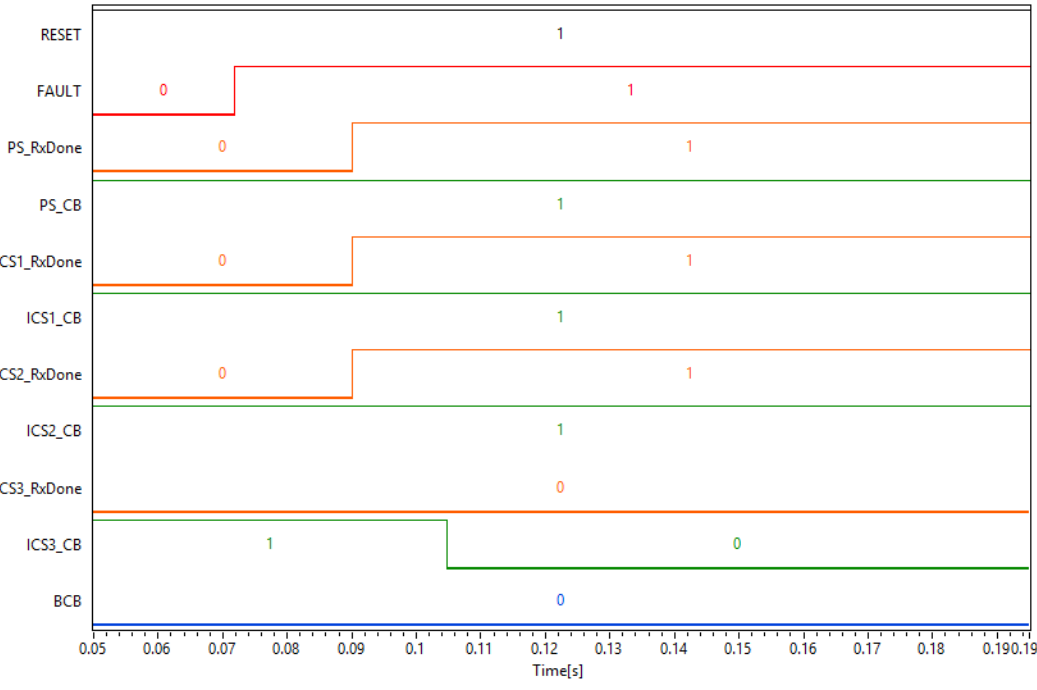
Figure 21. Acquired digital signals during the fault 50.S3 between PR3 and